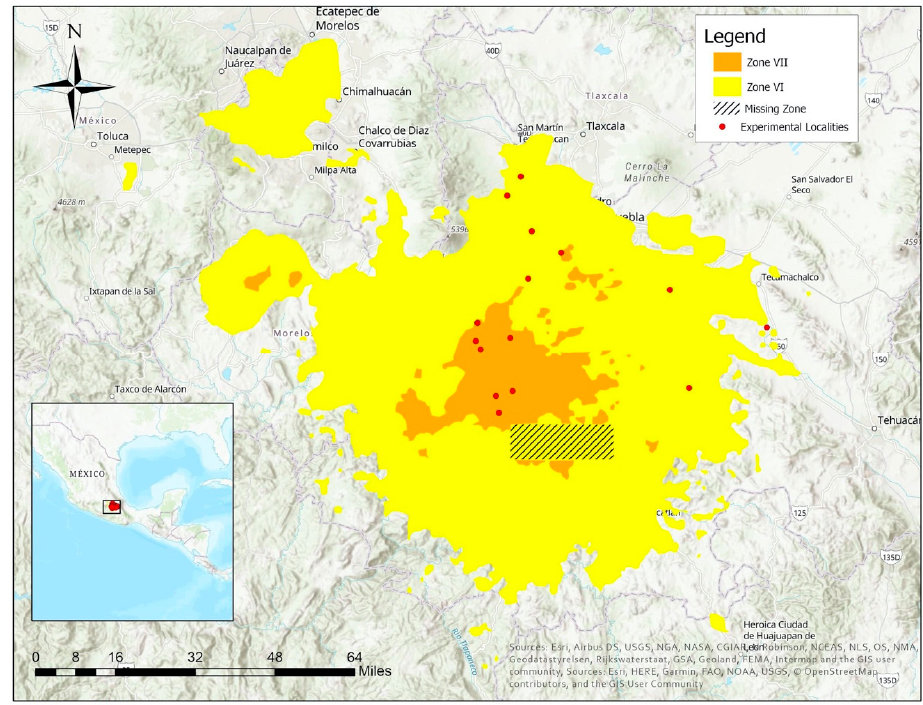
Figure 4. Map of the final 15 experimental localities, within the two strongest earthquake zones, that were used in the final analysis detecting localities that depopulated as a result of the 2017 Puebla earthquake [29].